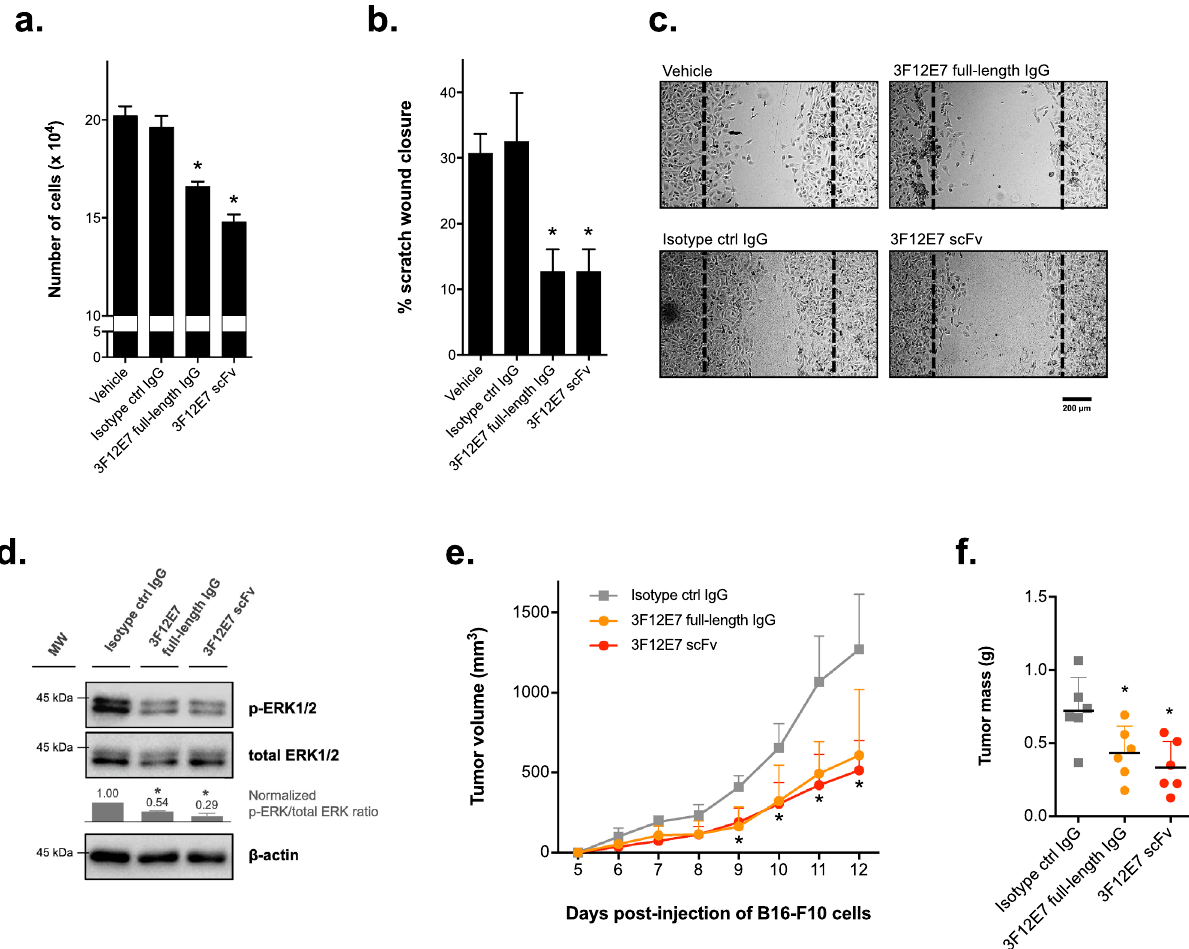
Figure 2. In vitro and in vivo functional effects of 3F12E7 anti-FGF2 scFv. 3F12E7 scFv reduces in vitro endothelial cell proliferation ( a ) and migration ( b ). Cells were incubated with 10 µg/mL of the indicated mAbs. No difference was detected between 3F12E7 scFv and 3F12E7 full-length IgG groups. Cell proliferation and migration were accessed by trypan blue exclusion and scratch assays, respectively. Representative micrographs of the scratch assay are on ( c ). Dashed lines indicate original wound edges. Scale bar, 200 µm. * P < 0.05 compared to isotype and vehicle controls; one-way ANOVA/Bonferroni’s post-test. ( d ) Immunoblotting analyses of ERK1/2 phosphorylation in HUVEC after 48-h incubation with the indicated mAbs (50 µg/mL). β-actin was used as loading control. Graph shows the quantitative densitometry of the immunoblot results. Data are mean ± s.d. of the relative intensity of the bands, normalized to that of isotype ctrl IgG group, from two independent assays. The full-length image scans and the result of an additional independent assay are provided in Supplementary Fig. S4a. ( e , f ) 3F12E7 scFv reduces xenograft tumor growth similarly to 3F12E7 full-length IgG mAb. ( e ) Tumor growth curve. ( f ) Excised tumor mass on day 12. Treatment started four days after subcutaneous injection of B16-F10 cells. Result (mean ± s.d.) is representative of two independent experiments. Experimental groups: isotype control full-length IgG antibody, n = 6; 3F12E7 full-length IgG mAb, n = 6; 3F12E7 scFv, n = 6. * P < 0.05 compared with isotype control group; one-way ANOVA/Bonferroni’s